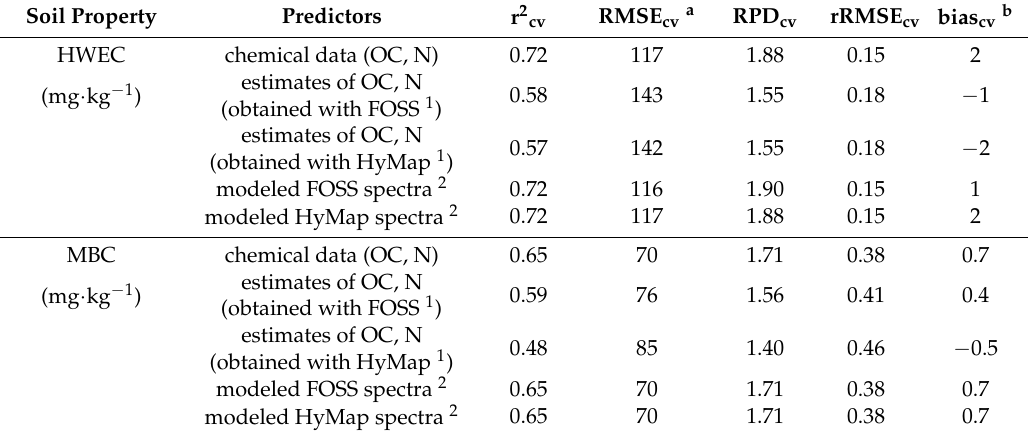
Table 6. Statistics of estimates for HWEC and MBC obtained with multiple linear regression (measured and estimated values for OC and N as predictors *) and with PLSR using modeled spectra (LOO cross-validated results, n =